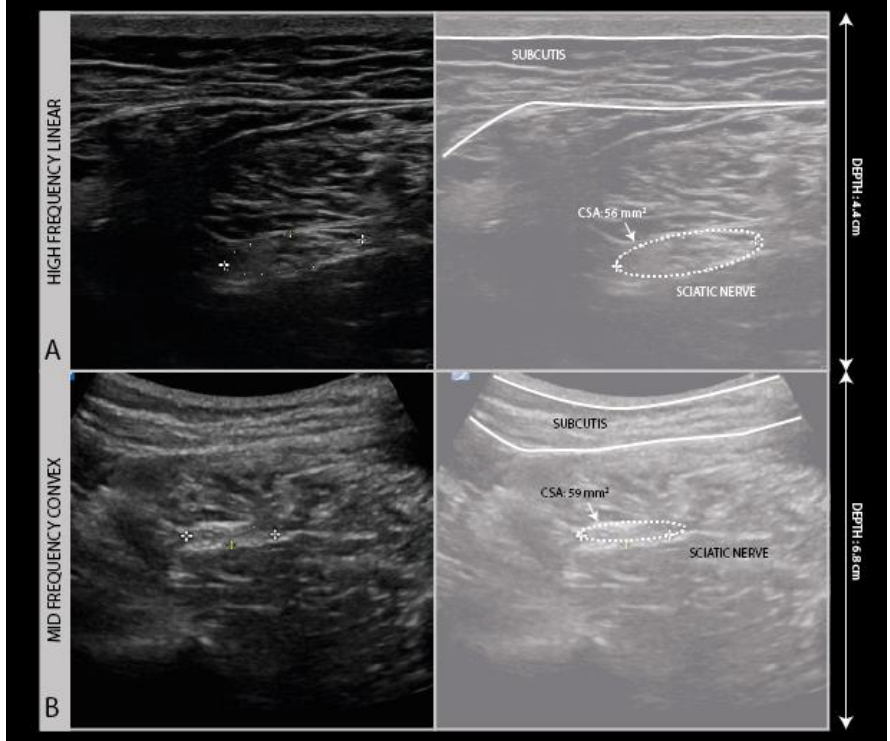
Figure 2. High frequency (5–16 MHz) probe image ( A ) compared to the low frequency (2–9